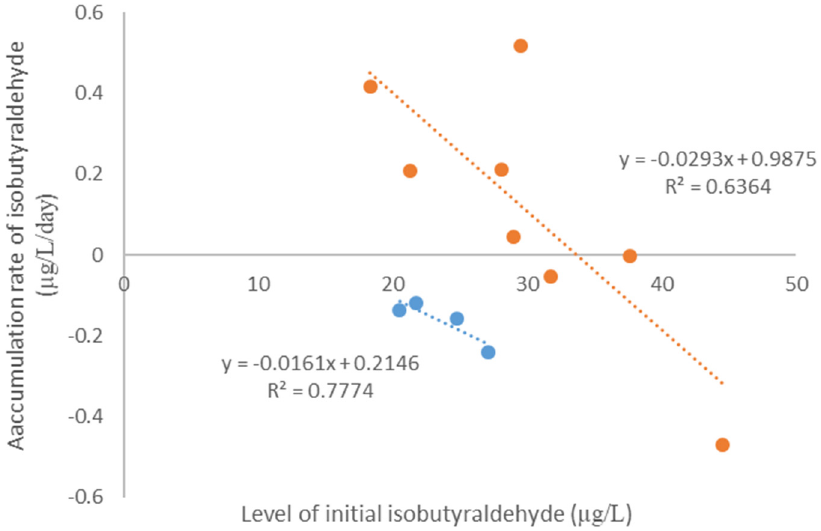
Figure 3. Correlation between isobutyraldehyde accumulation rate ( μ g/L/day) and initial concen- trations of isobutyraldehyde ( μ g/L). Blue dots correspond to white and rosé wines. The 8 reds are represented in orange.